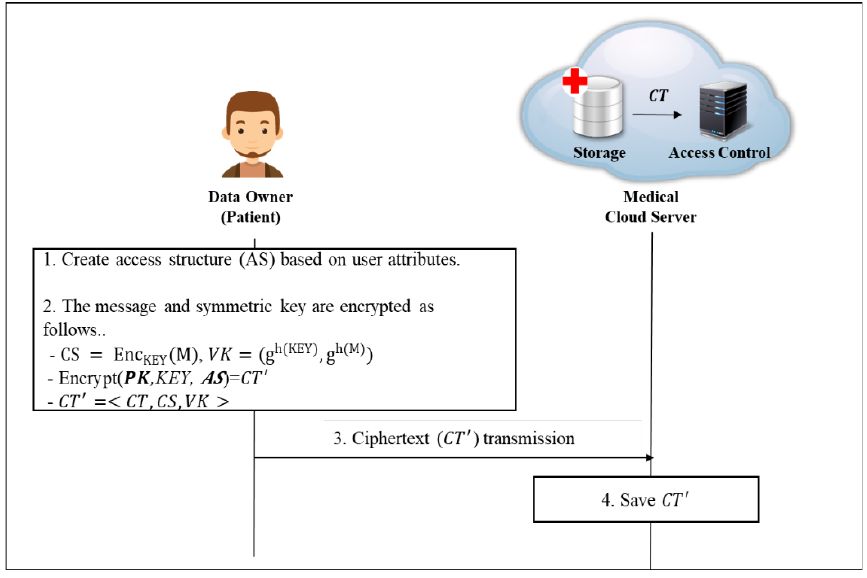
Figure 8. Data Encryption Phase.